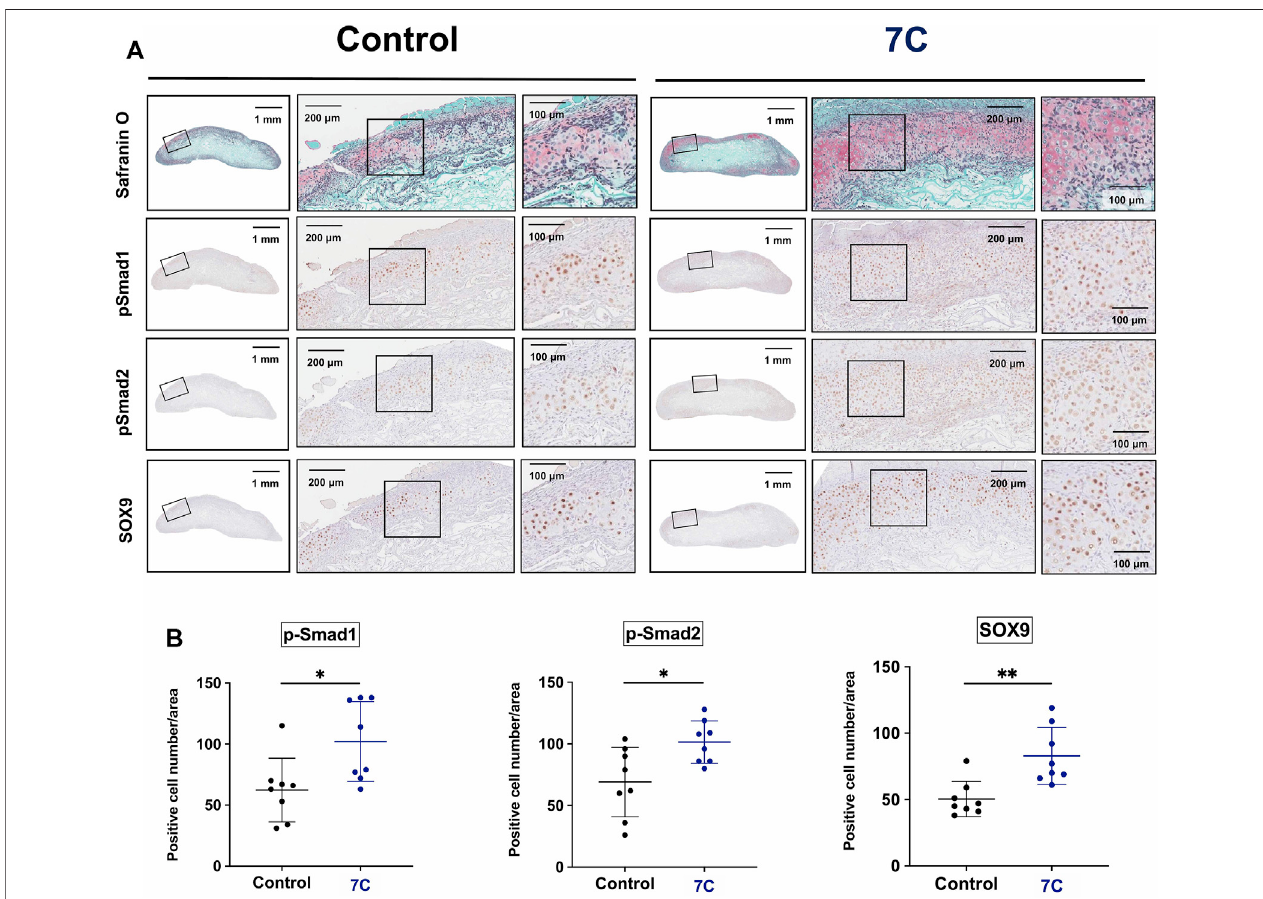
FIGURE 4 | Immunohistochemical staining of BMP-2 pellets on Day 7. (A) p-Smad1, p-Smad2, and Sox9 positive cells in the cartilage tissue of the BMP-2 pellets with blank-NPs (Control) and 7C-NPs (7C). (B) Quantitative analysis of positive cells. The immunopositive cells for p-Smad1, p-Smad2, and Sox9 were counted only in cartilaginous tissue formed in BMP-2 pellets. n = 8 per group, * p < 0.05, and ** p < 0.01.